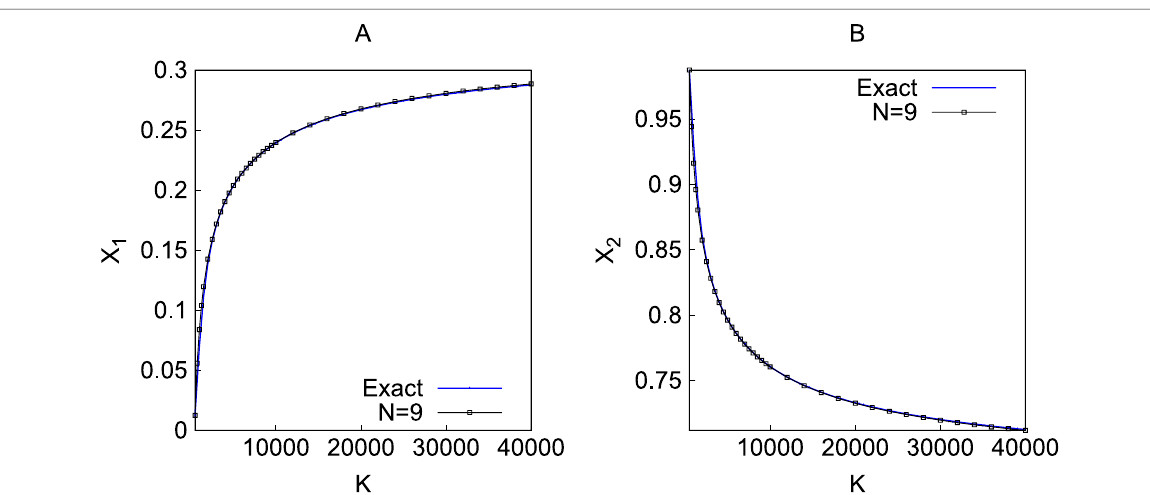
Fig. 13 Case (4) Parametric Study for Exact Solution and RRM. A Variation of x 1 with the soil stiffness ( K ). B Variation of x 2 with the soil stiffness ( K